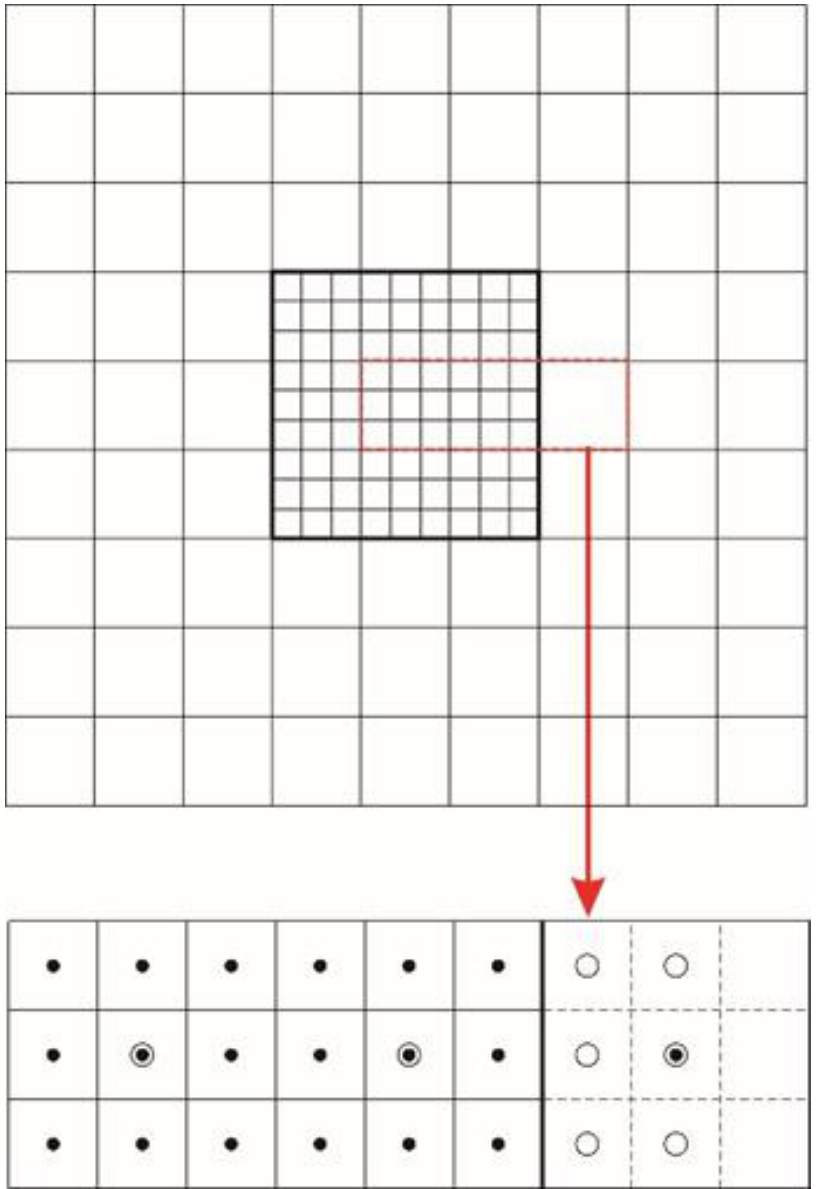
Figure 2. A schematic of the virtual-grid method. The bold lines are the nesting interfaces. In the zoomed-in view, bullets are the actual grid centroids and the hollow circles are the virtual grid ones. Computation of the HRG variables uses the variables at the refined virtual grid on the right side of the boundary, while the coarse virtual grid variables on the left side are involved in the computation of the CRG variables.